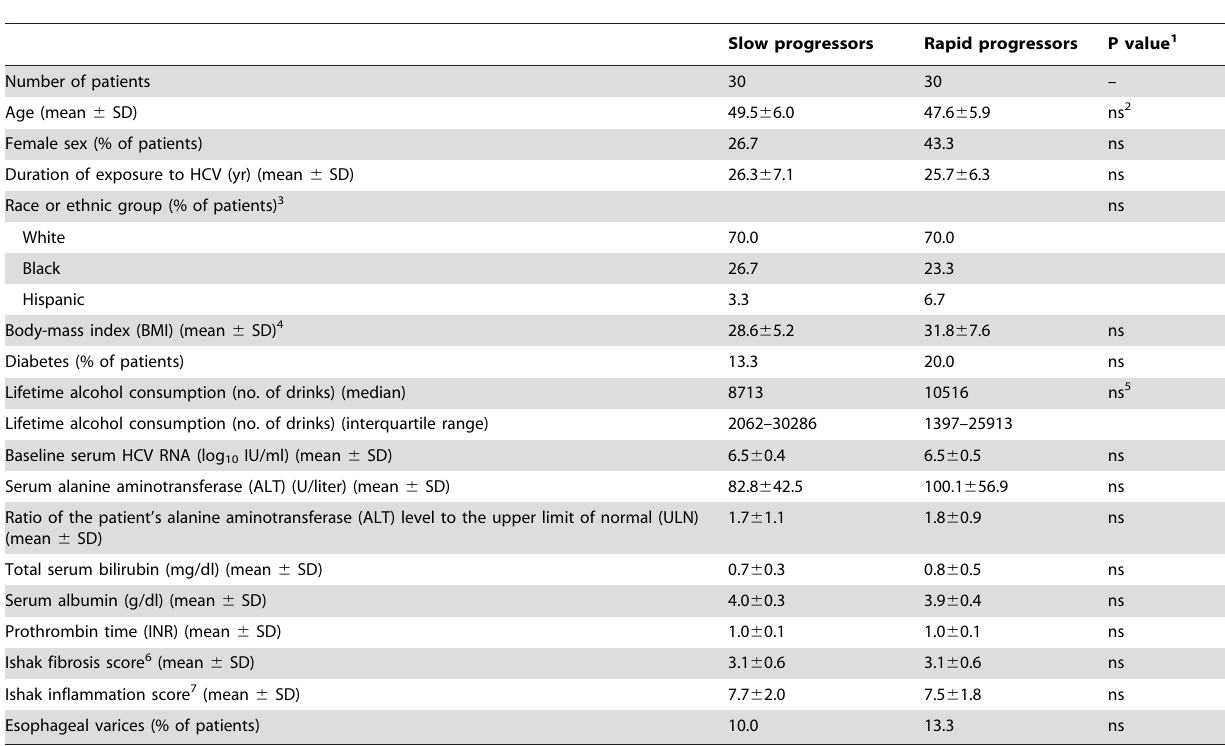
Table 6. Baseline characteristics of patients from whom the rapid and slow progressor samples were